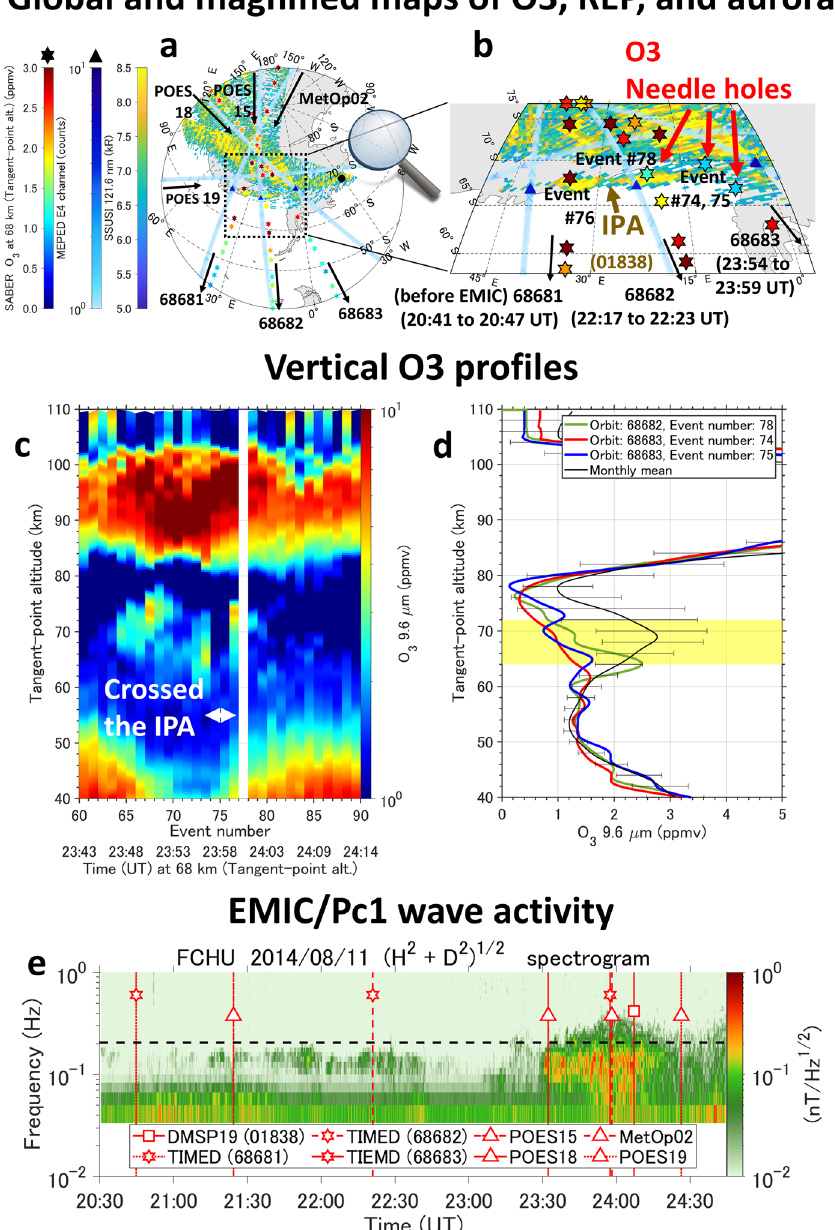
Figure 3. Localized ozone loss associated with EMIC-driven IPA in the absence of a storm. ( a ) Global map of the mesospheric ozone (SABER, stars), REP (MEPED, triangles ≥ 4 counts), and aurora (superposition acquired from 22:18 to 27:32 UT by DMSP19/SSUSI). The black dot indicates the magnetic conjugate point of Fort Churchill (FCHU), Canada. ( b ) Magnified map (aurora taken at 24:07 UT by DMSP19/SSUSI). Black arrows indicate the orbit direction of the TIMED and POES satellites and the time information in parentheses is the measurement time for TIMED/SABER. Maps were generated by MATLAB R2020b, https:// www. mathw orks. com. ( c ) Tangent altitude profile of ozone by orbit 68,683 through the IPA. ( d ) Difference in the mesospheric ozone profiles. e EMIC/Pc1 wave activity on August 11, 2014, at FCHU. The black dotted line is the O + gyrofrequency at the magnetic equator estimated from an empirical geomagnetic field model 41 . Red lines indicate the time each instrument passed the same magnetic latitude of the IPA (~ 63°). Numbers in parentheses denote the orbit number of each